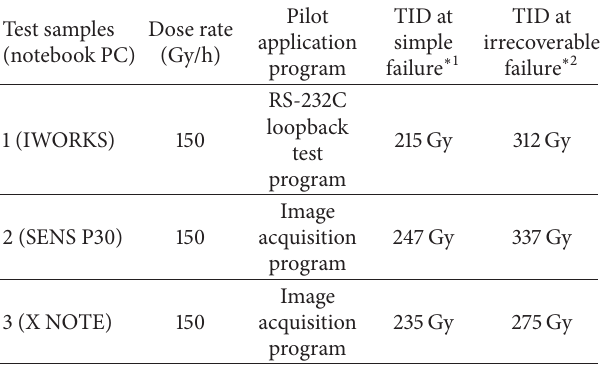
Table 1: Performance evaluation results of the notebook PCs under high dose-rate gamma ray irradiation